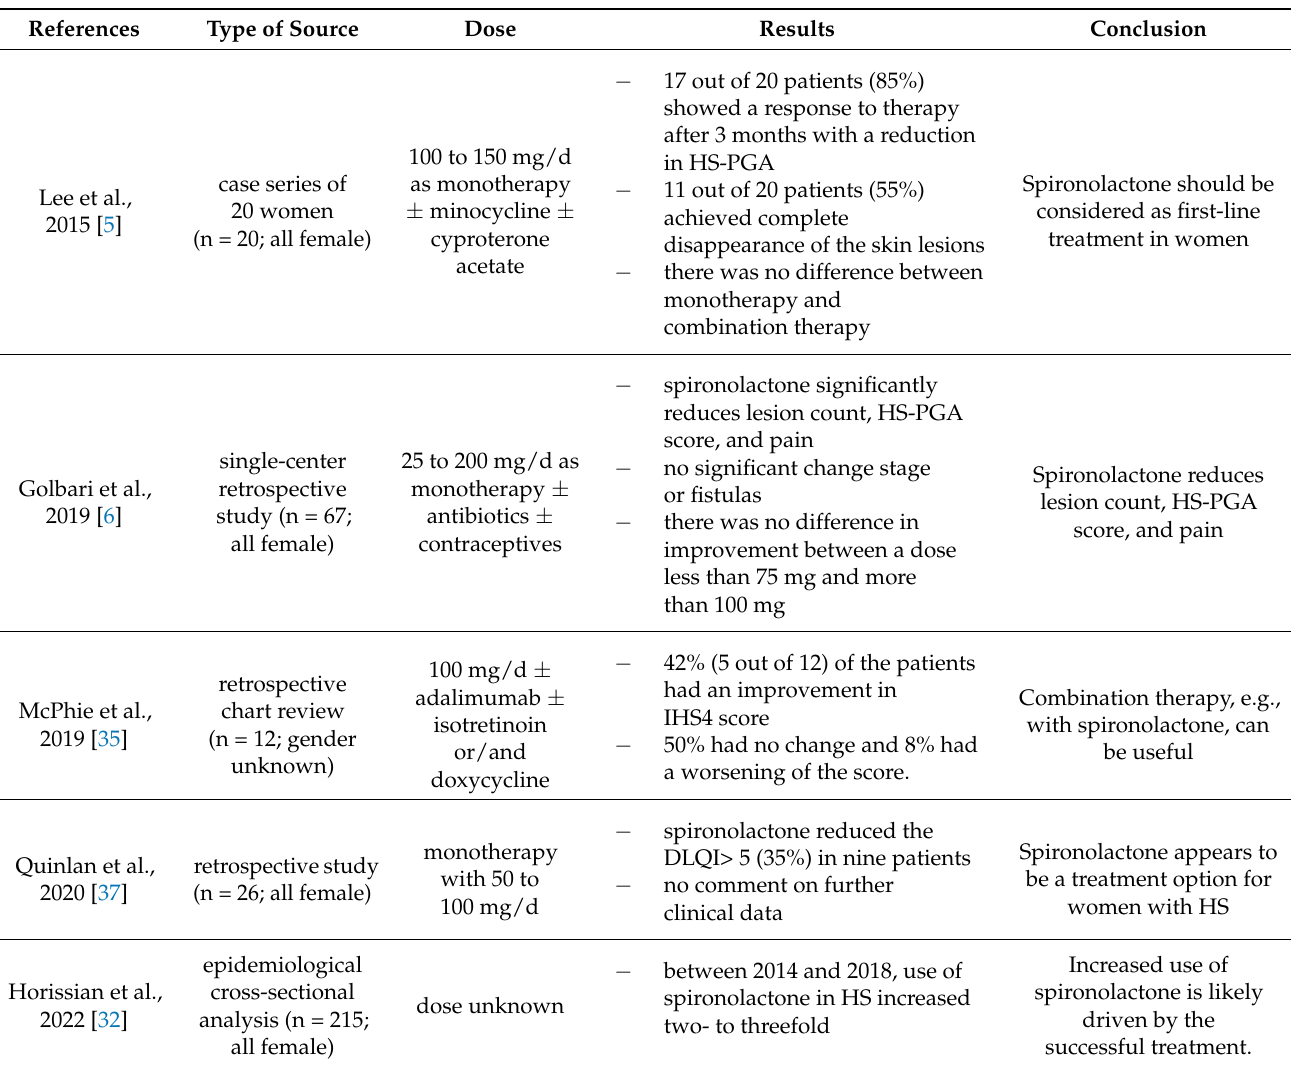
Table 4. Use of spironolactone (antiandrogen therapy, aldosterone antagonist) in